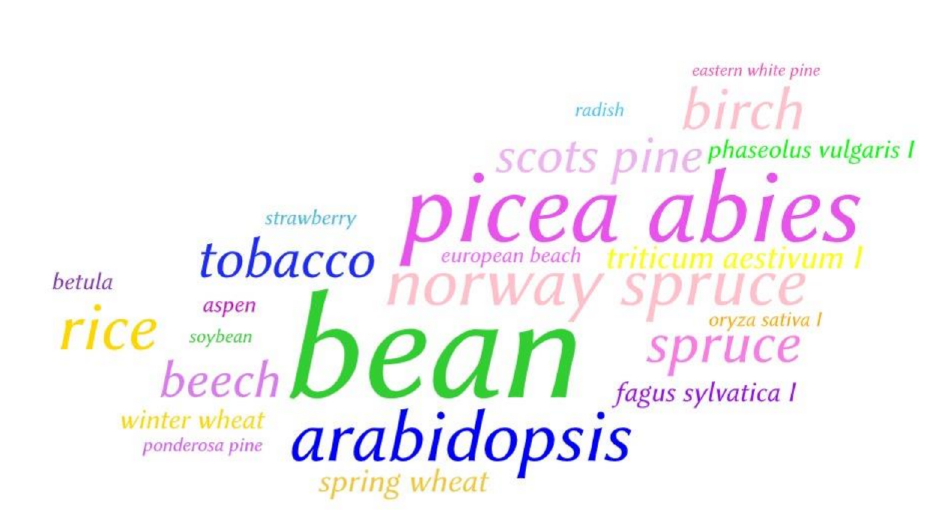
Figure 7. Word clouds based on worldwide research on ozone in the plant field. Plant species named more than 25 times in titles. The size of the word indicates the frequency of word occurrence. Leguminous plants are represented in green, the trees in pink, the cereals in yellow, and the rest, including model species, in